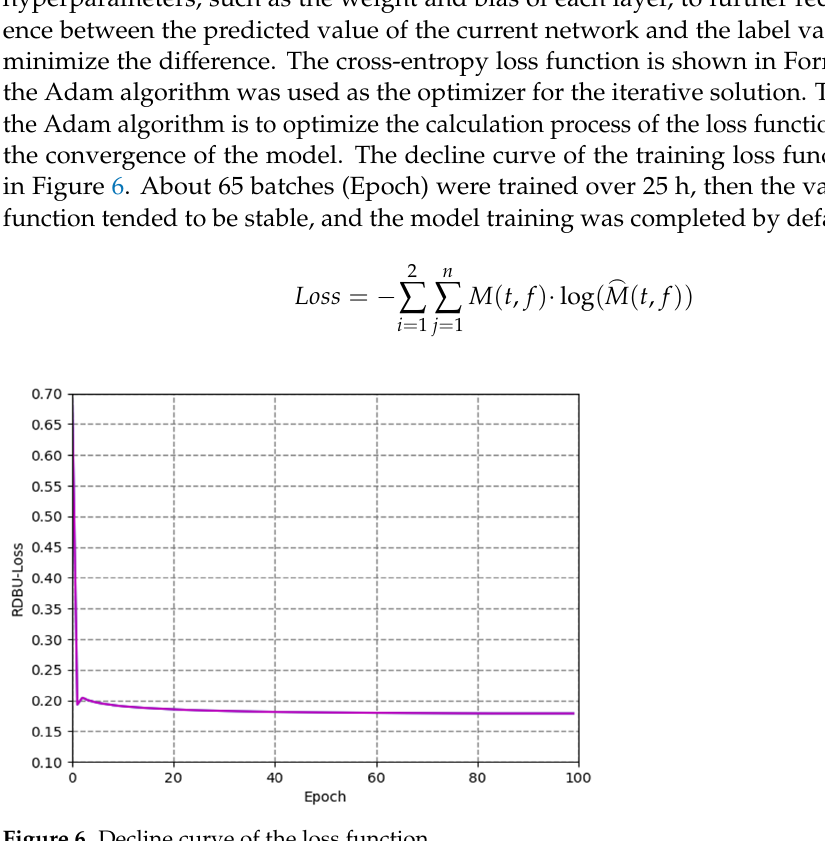
Figure 5. Basic experimental flow framework.